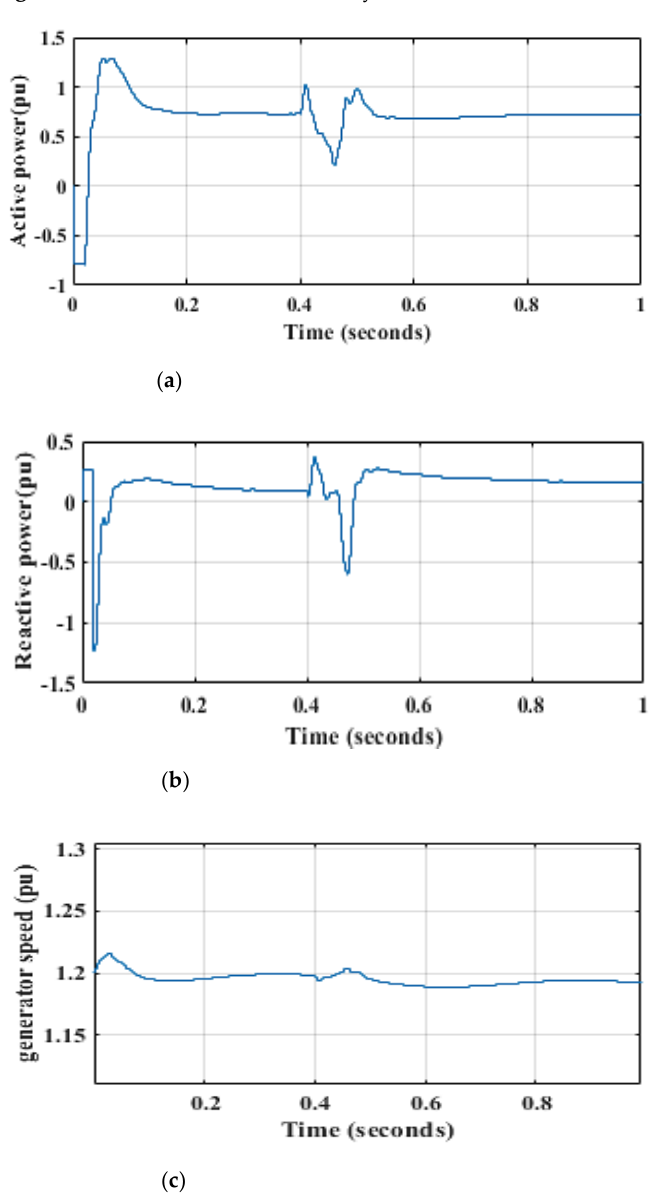
Figure 23. Grid current of the DFIG system under scenario III.